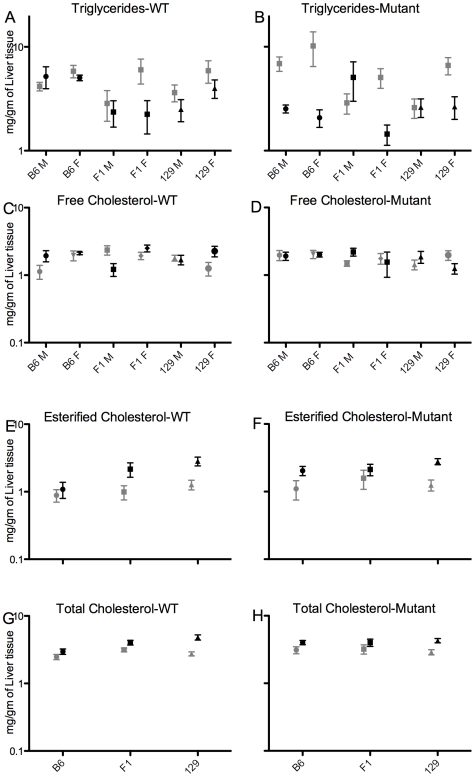
Hepatic levels of triglycerides and cholesterol are influenced by diet and Atp8b1 mutation.Hepatic triglycerides and cholesterol in WT (A, C, E, and G) and mutant (B, D, F, and H) mice of B6, 129, and F1 background after cholate (black) and control (grey) diet for 4–8 days; mean and SEM are shown. N's for cholate diet: B6 (n = 4−10), 129 (n = 8−20), and F1 (n = 4−9); and control diet: B6 (n = 4−11), 129 (8−19), F1 (n = 4−8).